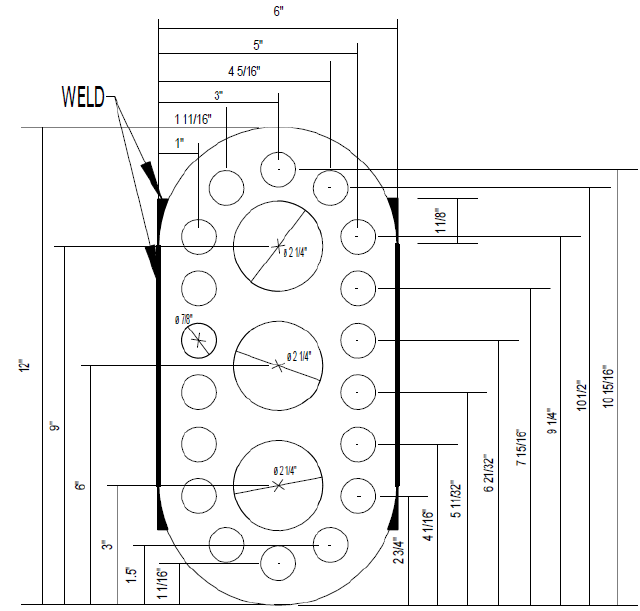
Figure 5. Shapes NS1 thru NS4.